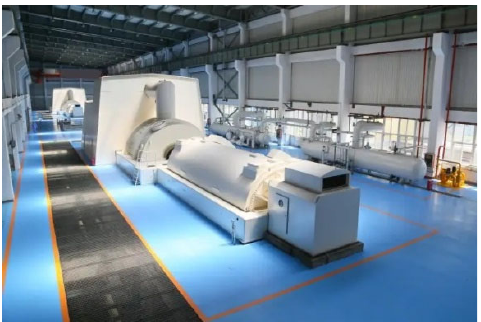
the whole. Therefore, the feasibility and accuracy of this algorithm are fully proven.